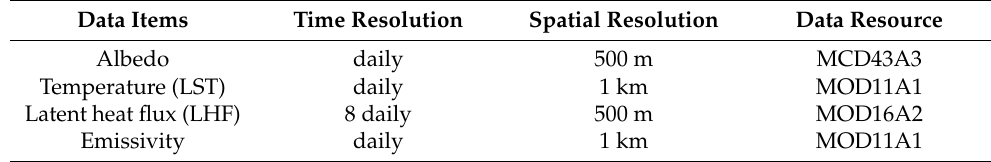
Table 1. MODIS data products items and descriptions.